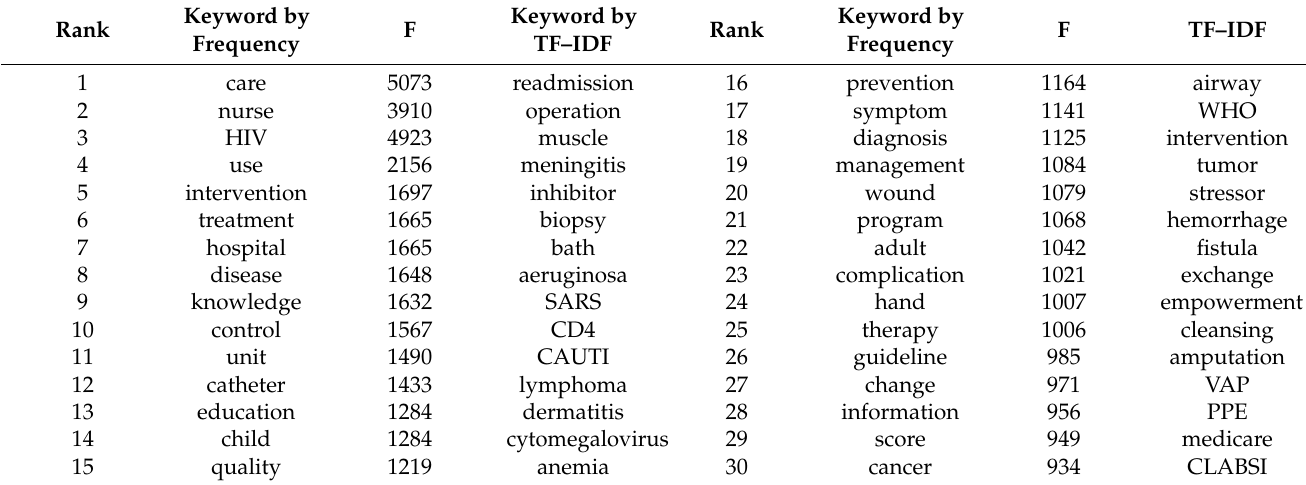
Table 2. Top 30 lexemes by frequency from infection research in nursing.